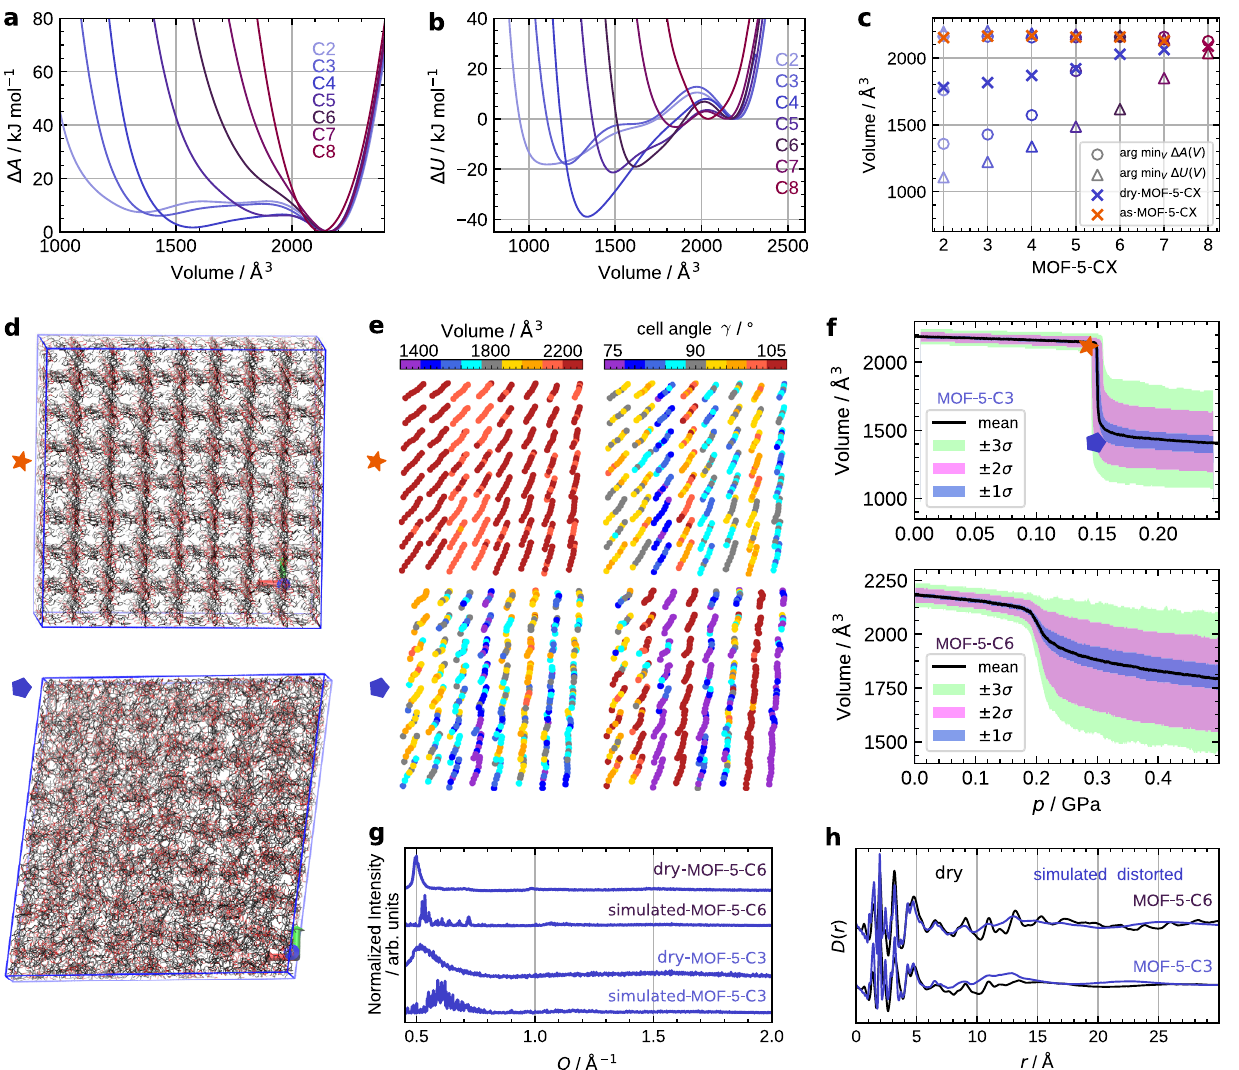
Fig. 4 Molecular dynamics simulation results. a and b Free energy Δ A and inner energy Δ U pro fi les with respect to volume; c Positions of the local energy minima of Δ A (circles) and Δ U (triangles) in comparison to the values estimated from experimental PXRD data (crosses). d Side view of MOF-5-C3 (large simulation box) before (red star) and after (blue pentagon) the pressure-induced phase transformation. e Individual cell volumes and angles γ of MOF-5- C3 at these points. f Distribution of individual cell volumes for MOF-5-C3 (top) and -C6 (bottom) with respect to pressure, the labels indicate where the snapshots for MOF-5-C3 were taken. g and h Simulated vs. measured PXRD patterns and XPDFs, respectively, for dry-MOF-5-C3 and